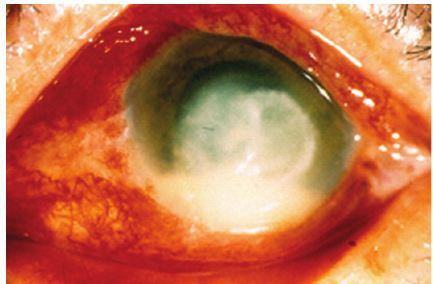
Figure 5: Fungal keratitis caused by melanized filamentous Alter- naria